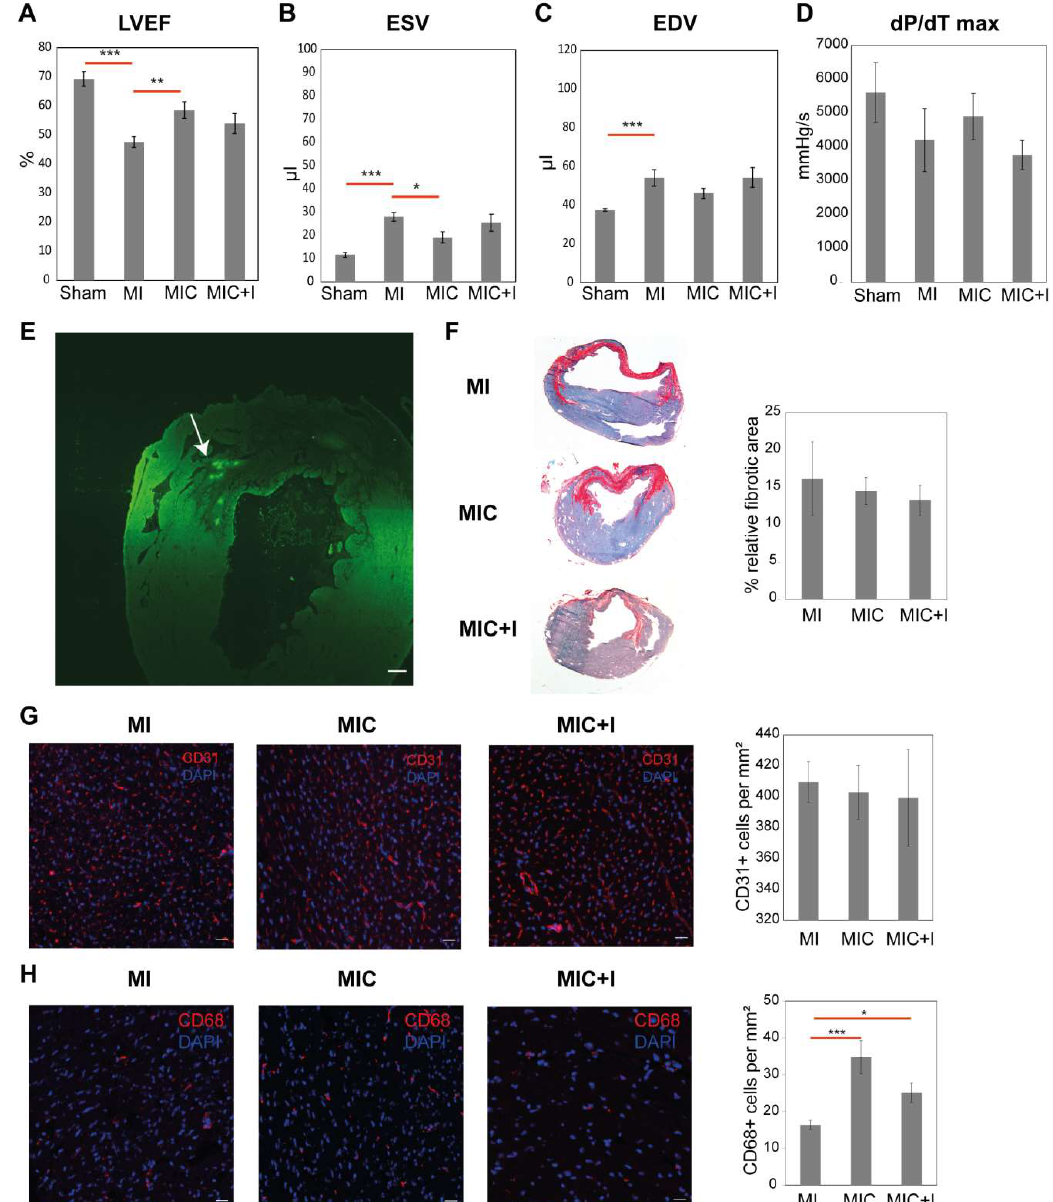
Figure 3. Syngeneic cardiomyocyte transplantation after MI leads to improved cardiac pump function and macrophage infiltration with no improvement in fibrosis and capillary density. Assessment of ( A ) Left Ventricular Ejection Fraction (LVEF,%), ( B ) End Systolic Volume (ESV, µL), ( C ) End Diastolic Volume (EDV, µL) using MRI ( n = 7) and pressure characteristics, ( D ) dP/dT max (mmHg/s) using conductance catheter ( n = 6 – 7) four weeks after MI. ( E ) A tile scan of the heart four weeks after cell transplantation with an arrow pointing towards GFP signals observed at the injection site. Scale bar represents 200 µm. ( F ) Assessment of fibrotic area in the heart after four weeks using Fast Green/Sirius Red staining ( n = 7). The heart slices were observed using a 10 × objective. ( G ) Assessment of CD31 + cells in the remote area of the heart four weeks after MI ( n = 7). CD31 + cells were stained red and the nuclei were stained blue using DAPI. Scale bar represents 20 µm. ( H ) Assessment of CD68 + cells in the remote area of the heart four weeks after MI ( n = 7). CD68 + cells were stained red and the nuclei were stained blue using DAPI. Scale bar represents 20 µm. Values are represented as the mean ± SEM. Significance was calculated using the Student‘s t -test and Mann–Whitney test. * p < 0.05, ** p < 0.01, *** p < 0.001.